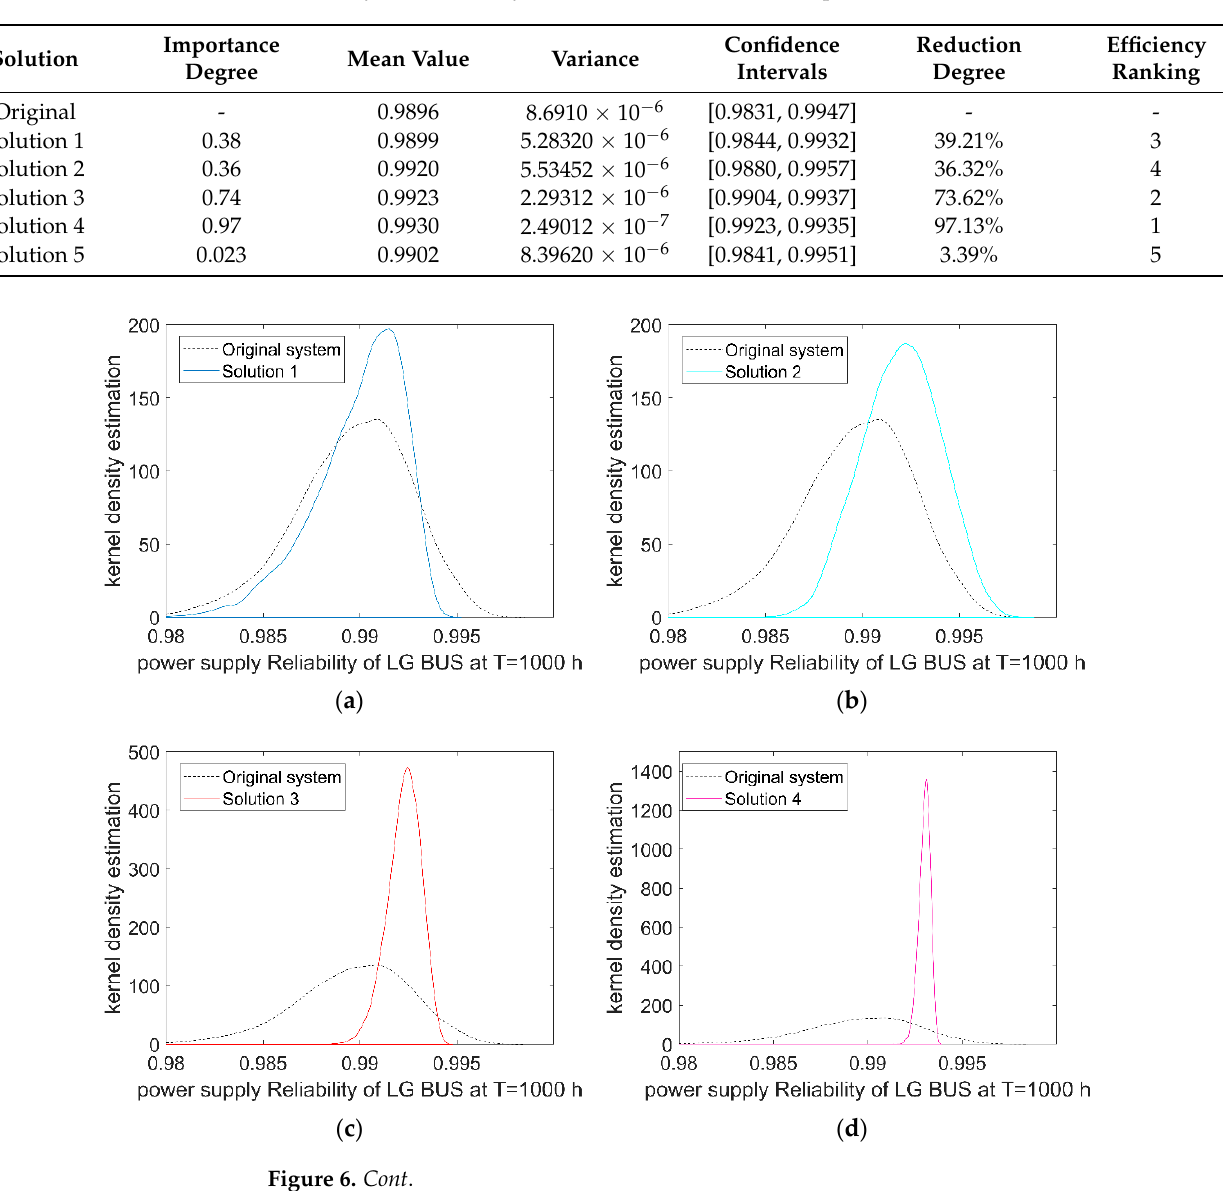
Table 6. System reliability of LG BUS under different improvement schemes ( T = 1000 h).